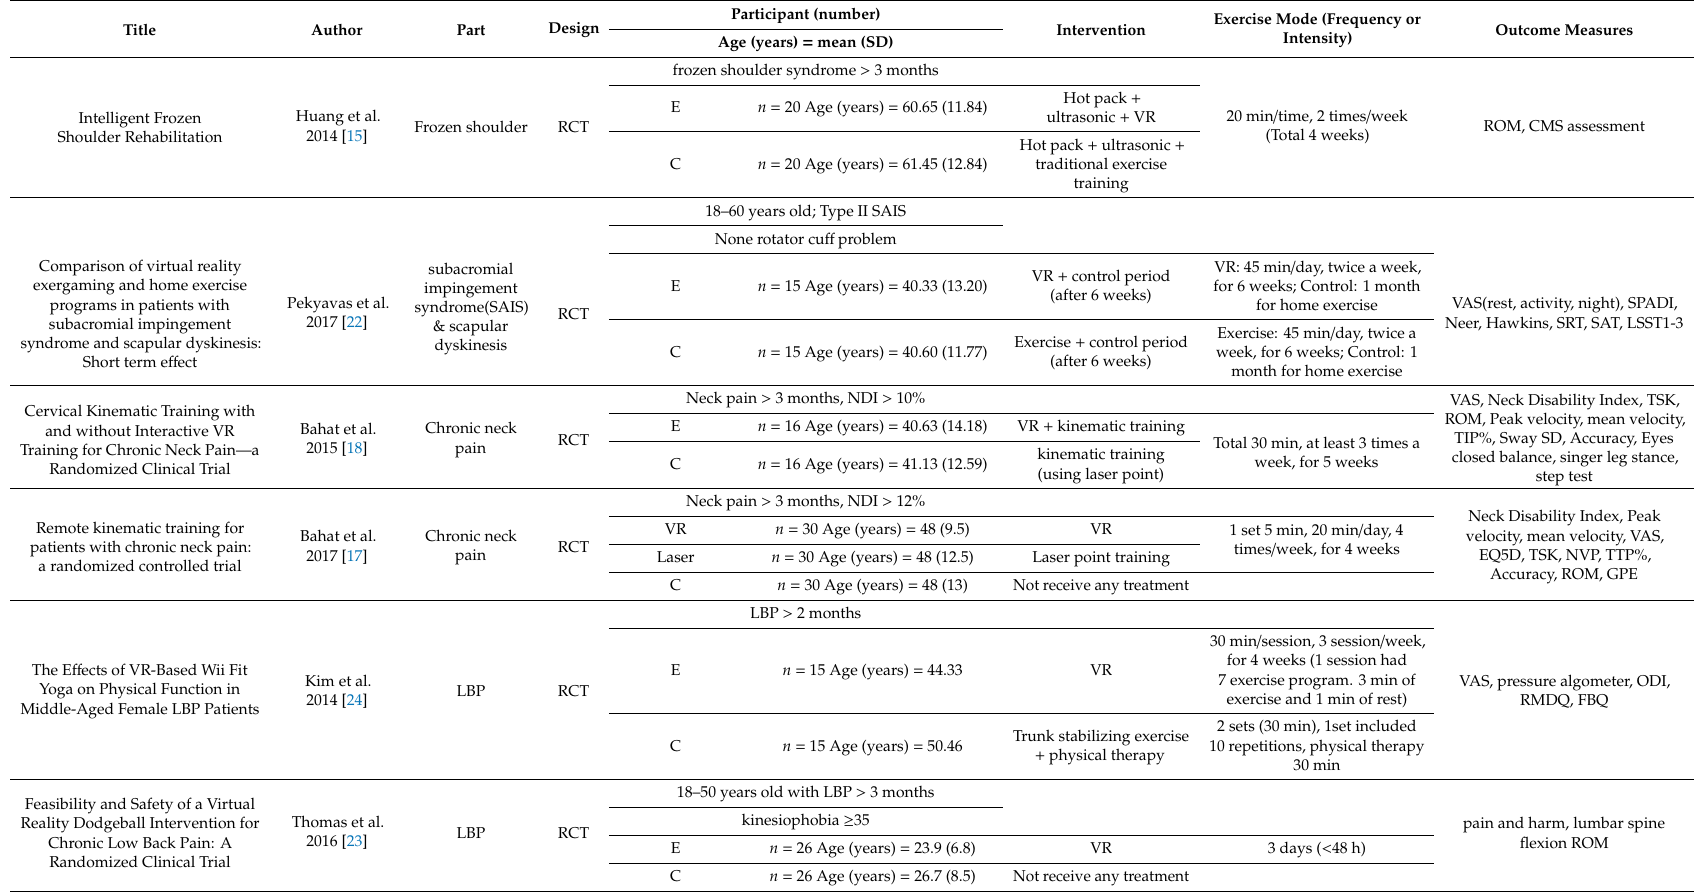
Table 2. Description of Included